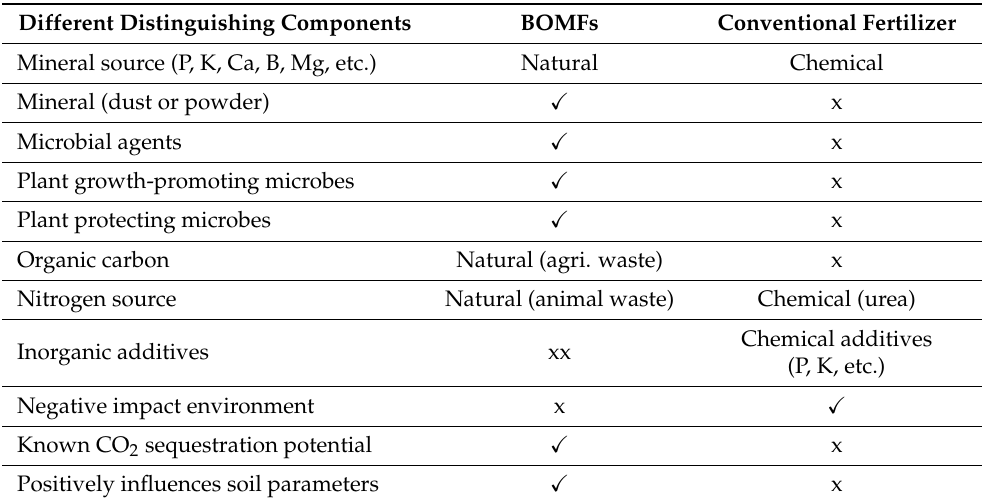
Table 1. Differences in compositional and functional attributes between BOMFs and conventional synthetic